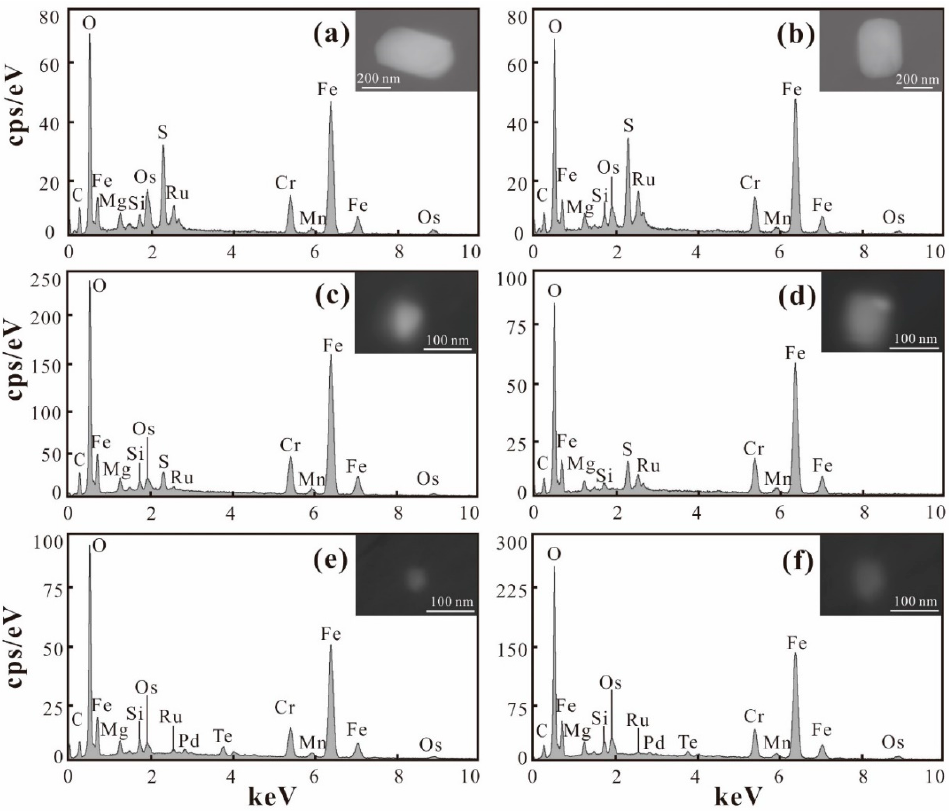
Figure 3. Energy dispersive X-ray spectrometry (EDS) and backscattered electron (BSE) images of platinum-group mineral (PGM) inclusions in chromite in the Xiadong dunites. ( a – c ) Ru–Os–S; ( d ) Ru–S; ( e , f ) Os–Ru–Pd–Te.